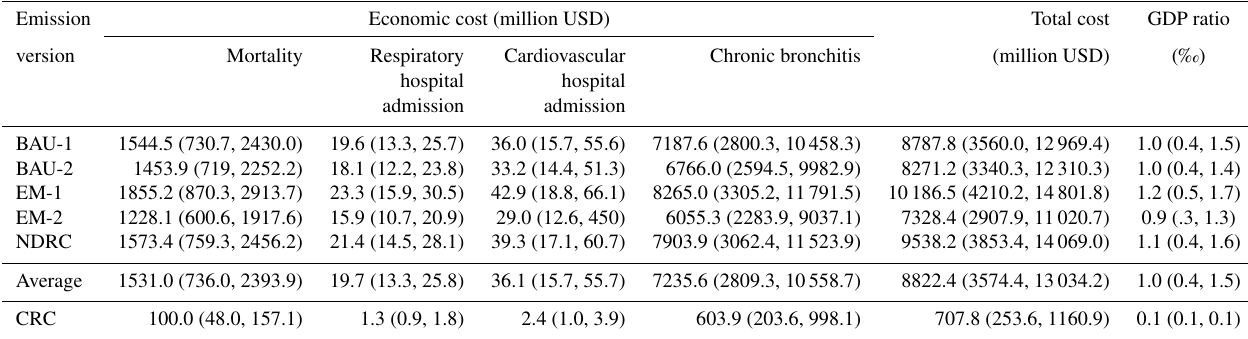
Table 8. Health-related economic loss (95%CI) from agricultural fire smoke PM 2 . 5 exposure in China in 2012.